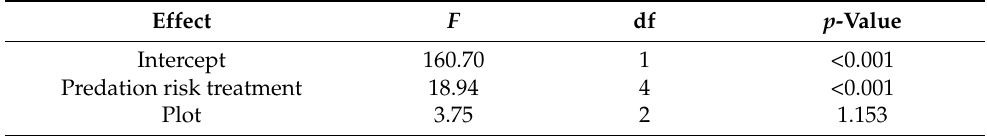
Table 2. Results of the GLMM, analysing the effect of experimental and environmental factors on O. longicaudatus faecal corticosterone metabolite levels.